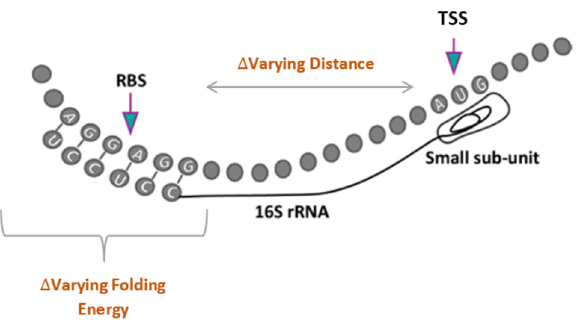
Figure A3. Considering preferred distance between RBS and start codon as well as mRNA-ribosome binding energy, affected by mRNA folding, to design a plasmid tailored for facilitating protein translation initiation in wanted hosts.